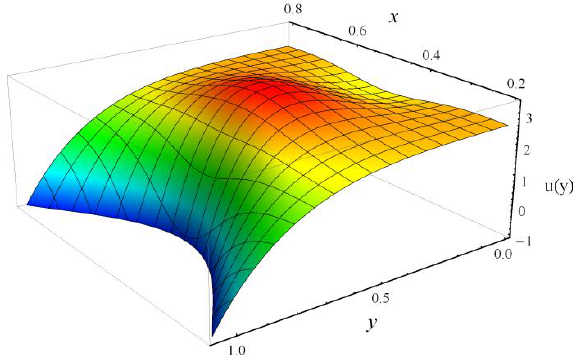
Coatings 2020 , 10 , x; doi: FOR PEER REVIEW Figure 3. The velocity profile for different values of variable M. Figure 3. The velocity profile for di ff erent values of variable M.